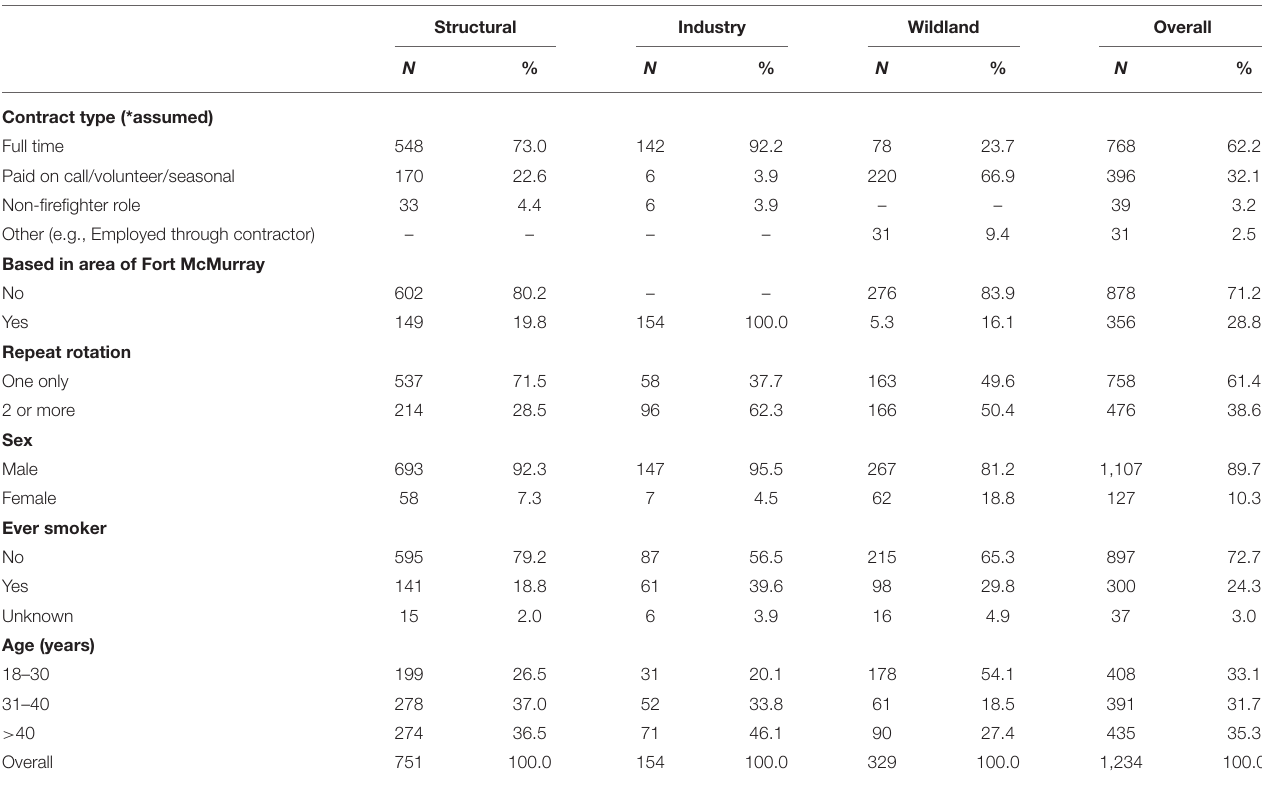
TABLE 1 | Characteristics of firefighters deployed to the fire. Structural Industry